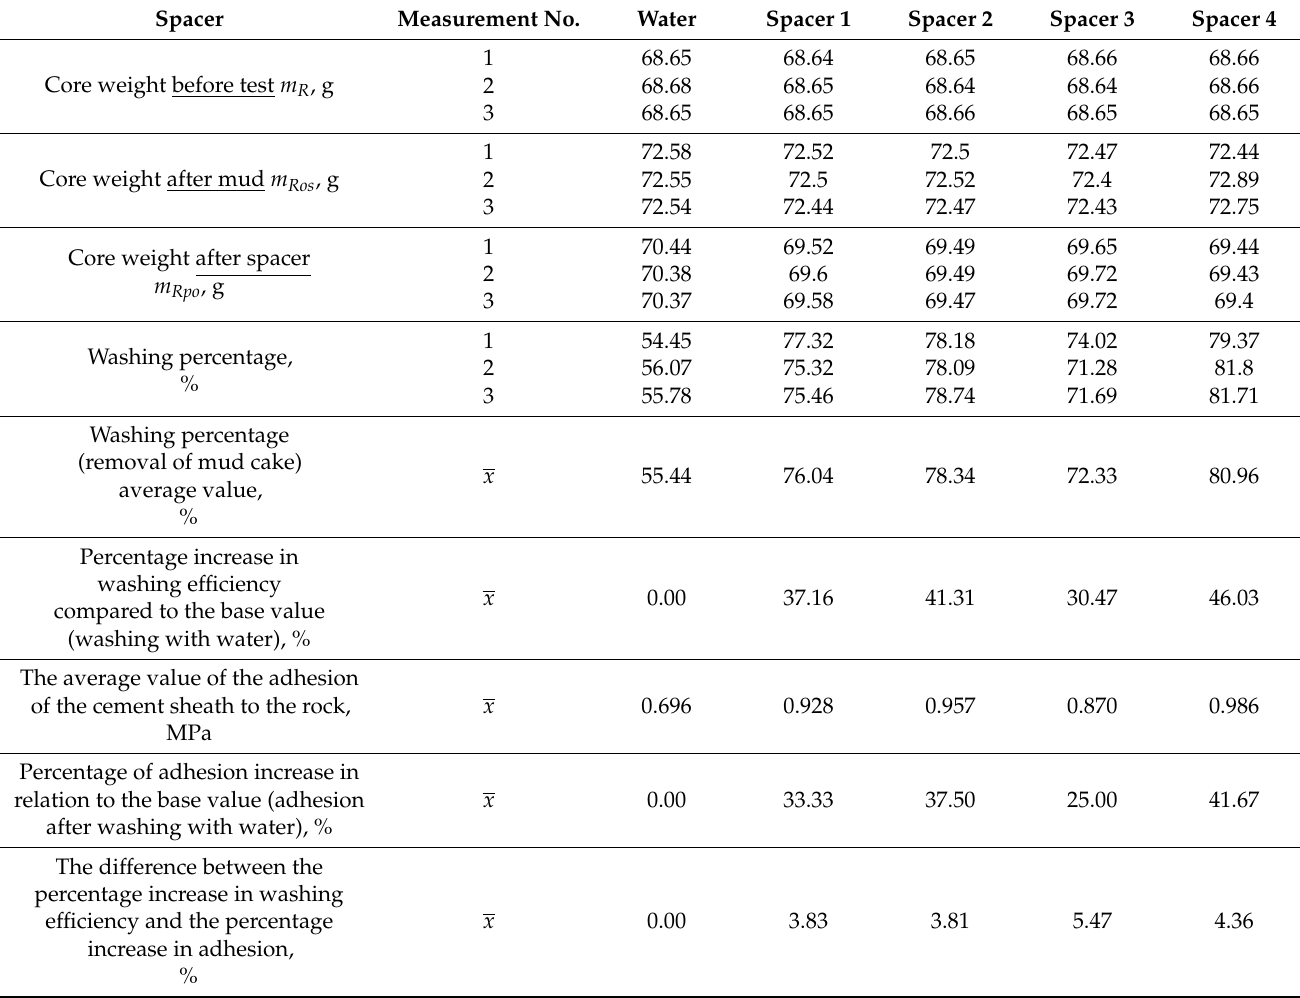
Table 2. The results of the research on the efficiency of the mud cake removal from the core surface and the adhesion of the cement sheath to the rock